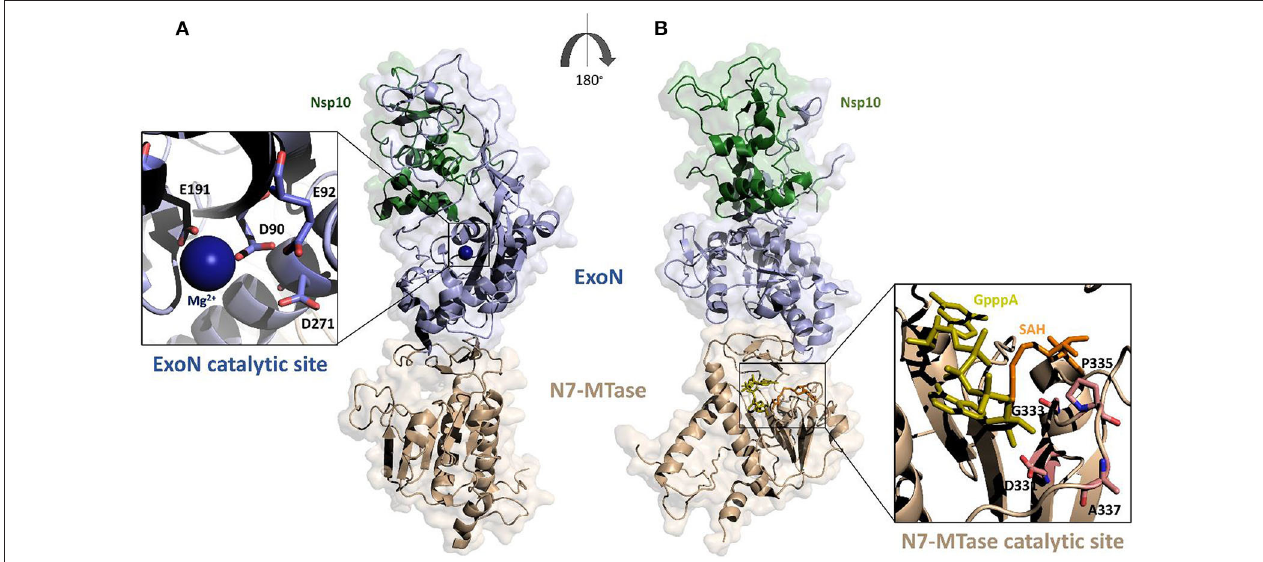
FIGURE 4 | Surface representation of the homology model of SARS-CoV-2 Nsp14-Nsp10 complex. The model was calculated using MODELER and the structure of SARS-CoV Nsp14-Nsp10 complex as a template (PDB code 5c8s, region 1-131 of Nsp10 and 1-525 of Nsp14); (A,B) panels show 180 ◦ views, to highlight catalytic sites of the two functional domains of Nsp14. The ExoN domain is shown in light blue and N7-MTase domain in wheat color. Zooms of the catalytic sites are shown (cartoon and stick representations) in the insets. The functional ligands of the N7-MTase domain (SAH, the demethylated form of SAM and GpppA), are represented as sticks, respectively in orange and olive (Ma et al.,